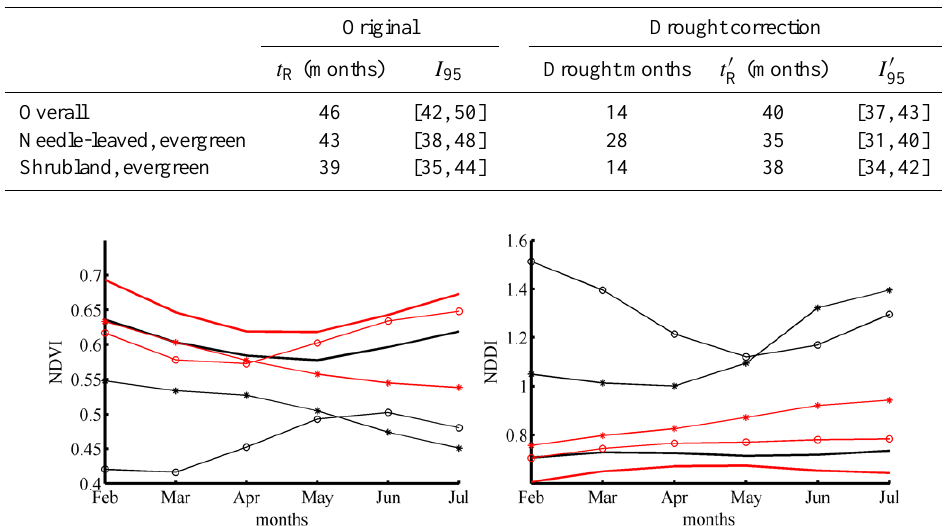
Table 2. As in Table 1 but with regard to A3, values computed for all pixels and for each of the two main land-cover types, according to GLC2000.